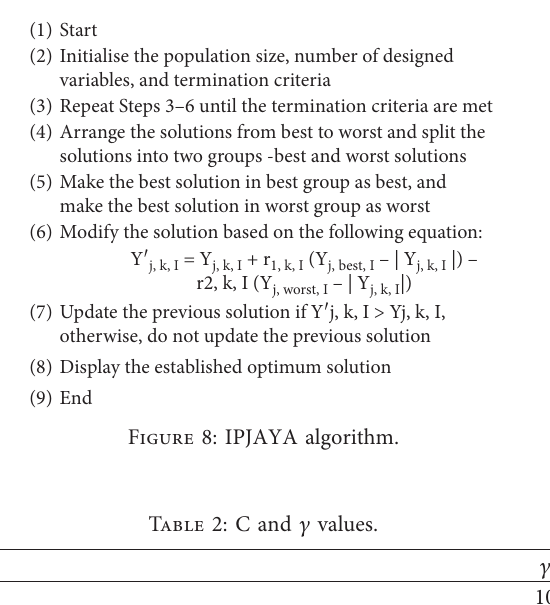
Figure 7: IPJAYA flowchart.